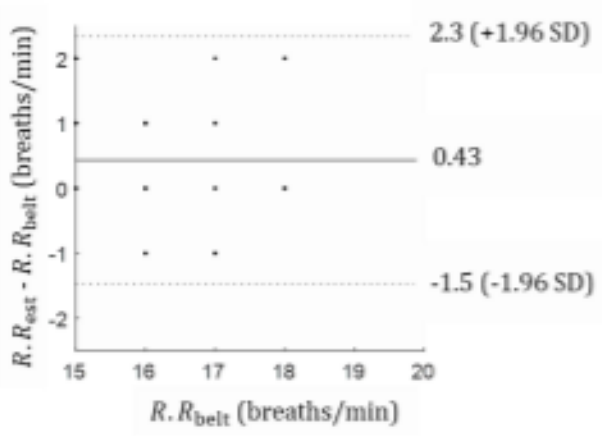
Figure 7. Bland-Altman results between the respiration belt and accelerometer sensor. R.R est : average respiration counts per minute acquired using